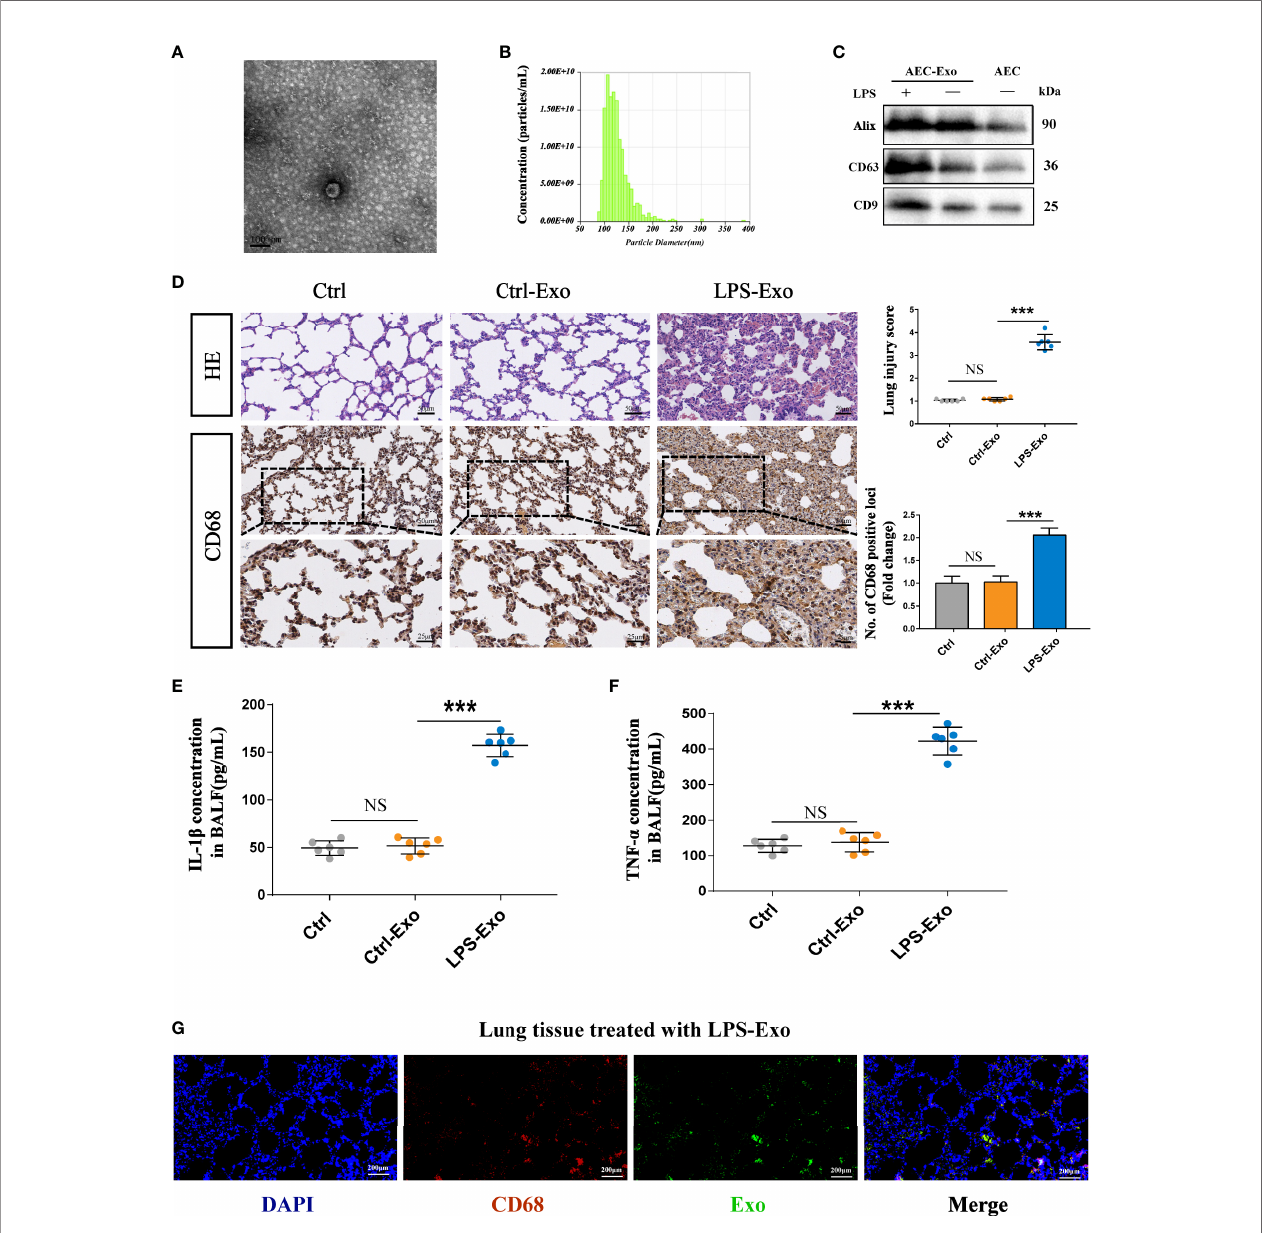
FIGURE 2 | Exosomes derived from LPS-treated AECs induce acute lung injury. (A – C) Characterization of exosomes isolated from the supernatant of cultured AECs. (A) Electron micrograph of exosomes. Scale bar, 100 nm. (B) Exosome size distribution was measured by Nano Sight tracking analysis. (C) Alix, CD63 and CD9 protein expression in exosomes was quanti fi ed by western blot loaded with equal amounts of protein (40 m g). (D – G) Exosomes (2 mg/kg) were intratracheally transferred to SD rats through intratracheal, and analysis was performed 24 h after treatment (n = 6 for each group). (D) Lung histological changes and lung injury scores were assessed with HE staining. Immunohistochemical detection of CD68 positive macrophage in fi ltration in the lung. The numbers of CD68 positive loci were quanti fi ed with ImageJ software. Scale bar, 50 m m and 25 m m. (E, F) ELISAs showed the expression of proin fl ammatory cytokines (IL-1 b and TNF- a ) in the BALF. (G) LPS-Exos labelled with PKH-67 fl uorescent dye were administered to rats. Immuno fl uorescence images showing the colocalization between exosomes (green) and CD68- labelled AMs (red) in the lung. Nuclei were counterstained with DAPI (blue). Data are presented as the mean ± S.E.M. ***P < 0.001 compared between two groups. NS, no signi fi cant difference. n=6 per